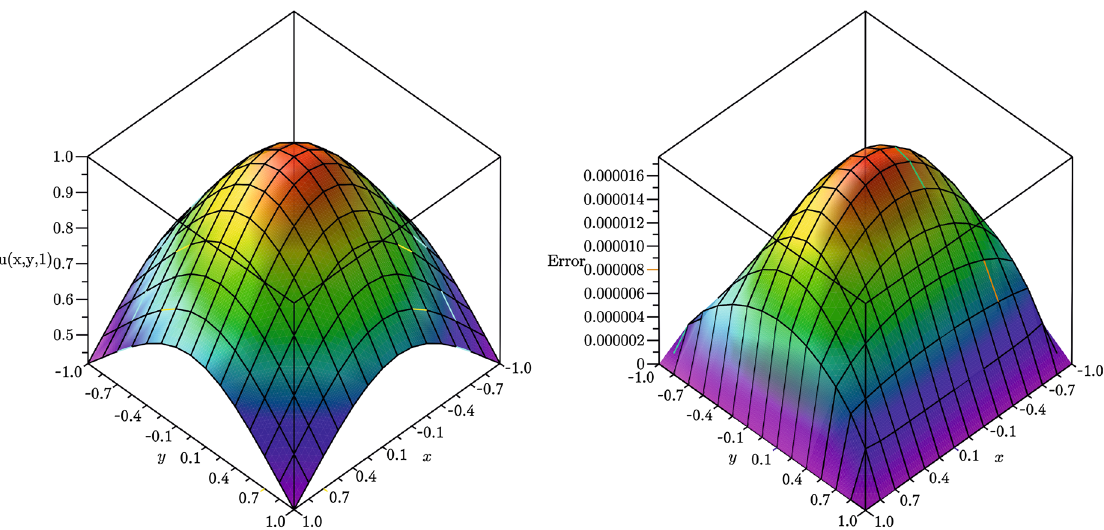
Fig. 4 The graphs of approximate solution (left) and absolute error (right) for M 1 = M 2 = 15, α = 0 . 35, τ = 0 . 02 and t = 1 by using MQ-RBFs with c = 1 . 95 in Example 3 RBFs as collocation points. The three formulas introduced in [6] were applied for approximating